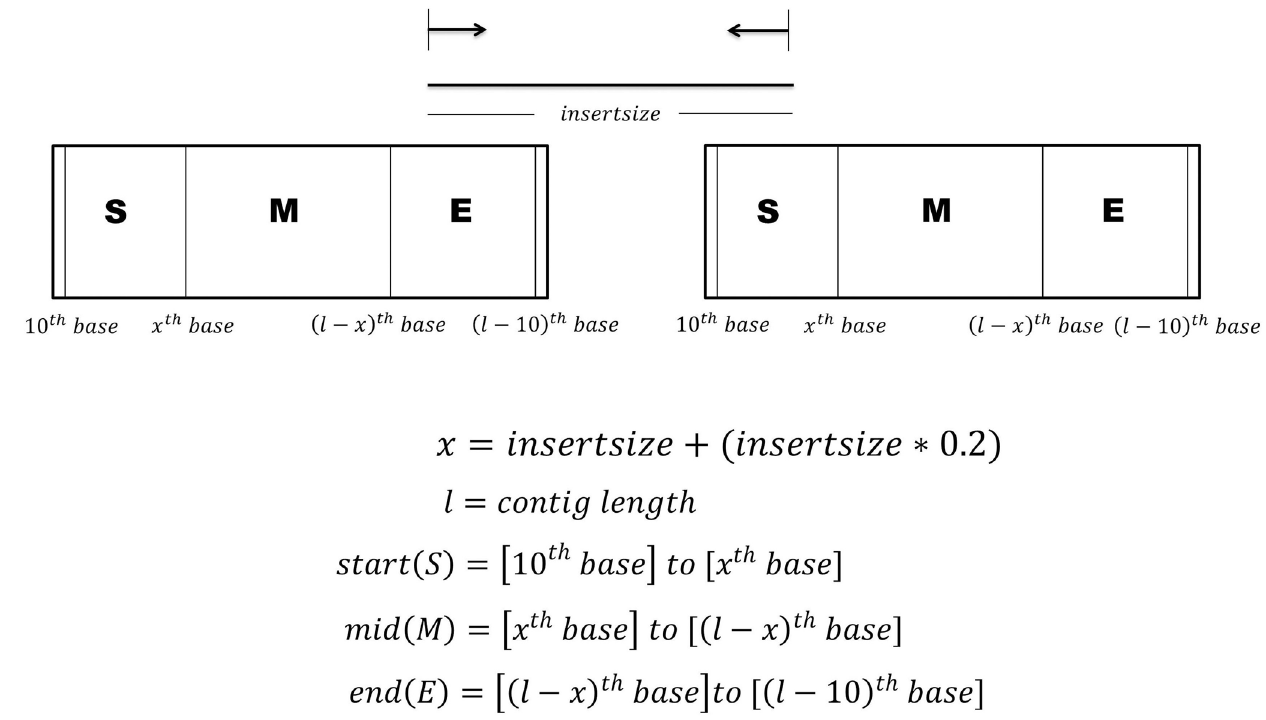
Fig 2. Defining the start and end of a contig based on the insert size. Connectivity between two consecutive contigs is decided by the paired reads from a single insert. To find such connections between contigs, each contig is theoretically divided into start, mid and end regions based on the insert